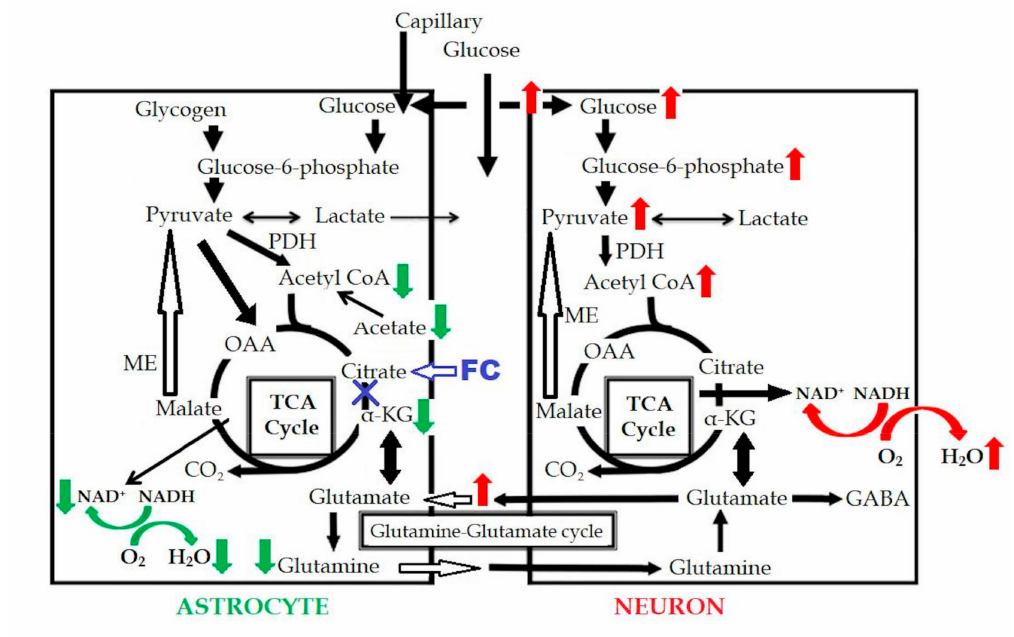
Figure6. SchemaofFC-inducedchangeintheastrocyticmetabolism. Redarrowsindicatedtheincreased metabolism, green arrows indicated the decreased metabolism, and blue “X” indicated the metabolic inhibition. OAA: oxaloacetate; GABA: gamma-aminobutyric acid; PDH: pyruvate